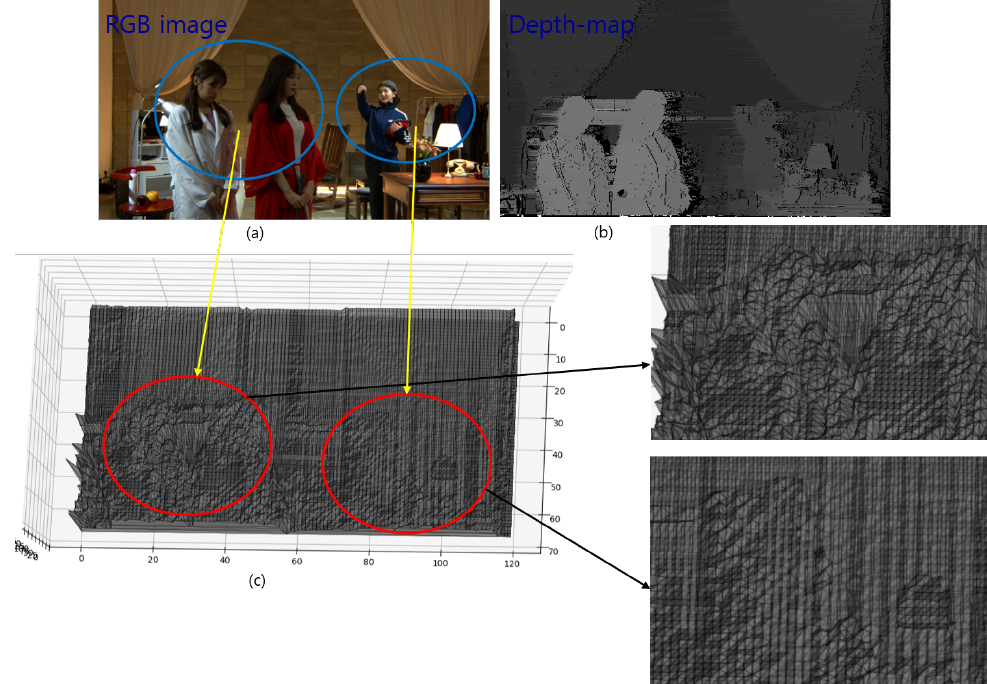
Figure 12. Depth map information is added to the triangle to generate the mesh. ( a ) Input image.